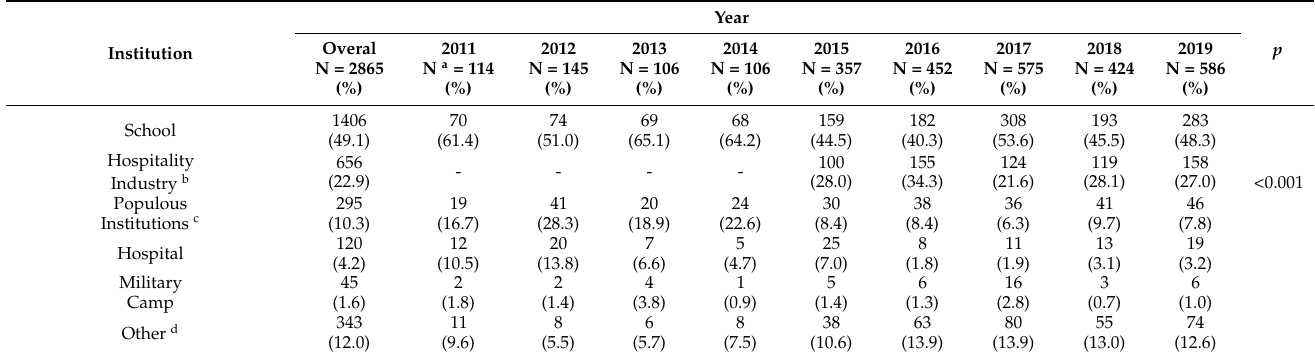
Table 4. Institutions where diarrhea clusters took place in Taiwan,